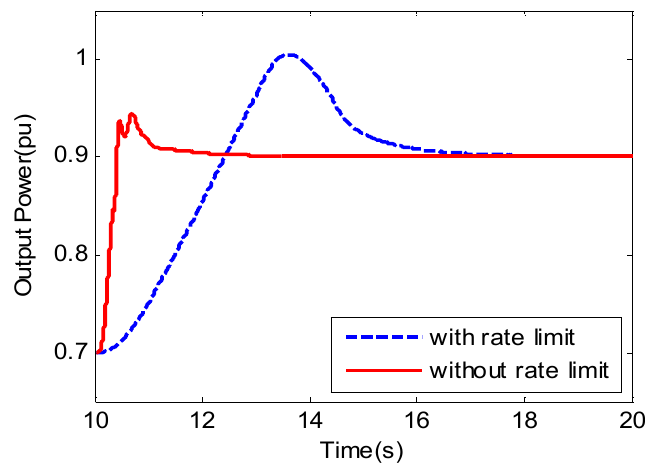
Figure 12. Power response of different rate limits.